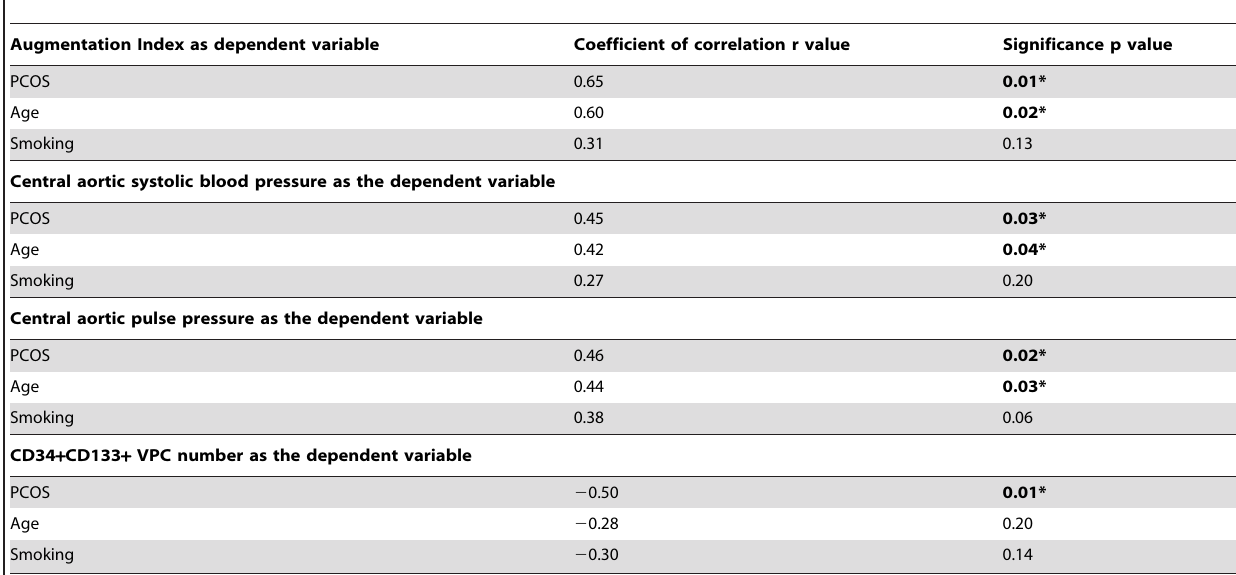
Table 2. Univariate correlations of AIx, central arterial pressures, and CD34 + CD133 + VPC number with PCOS diagnosis, age and smoking.